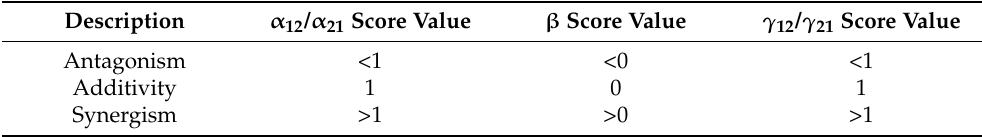
Table 2. Drug interaction classification based on alpha, beta, and gamma scores (Synergy